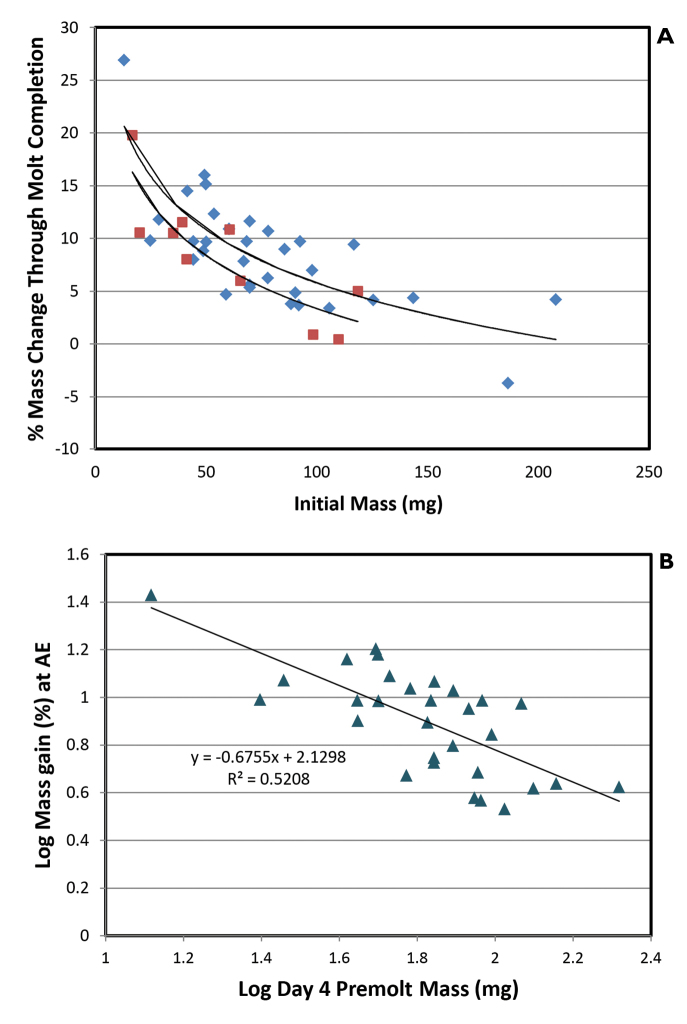
A Percentage mass change between 5 days premolt and anterior ecdysis for Armadillidiumvulgare maintained in 100 % RH (blue) and 97 % RH (red) and plotted as a function of premolt mass. Trendlines show best-fit logarithmic curves. Animals in 97 % RH achieve slightly smaller proportional mass changes to those in saturated air, consistent with the reduced vapor pressure gradient for WVAB Log-log plot showing the relationship between fractional mass-gain and pre-molt mass in 100 % RH (% mass gain α M-0.676).